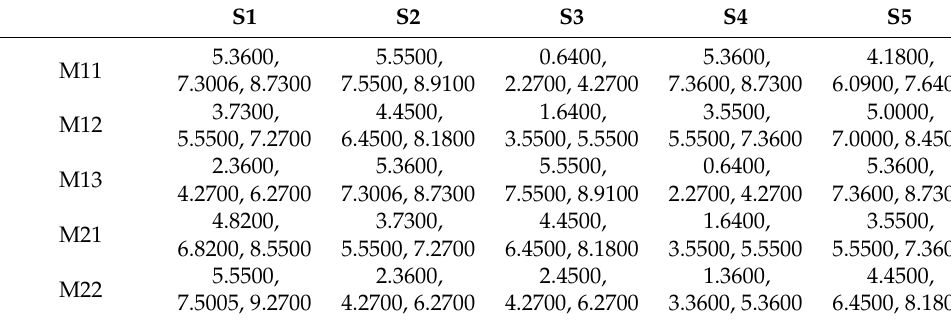
Table 15. Evaluators’ subjective intelligence findings in linguistic